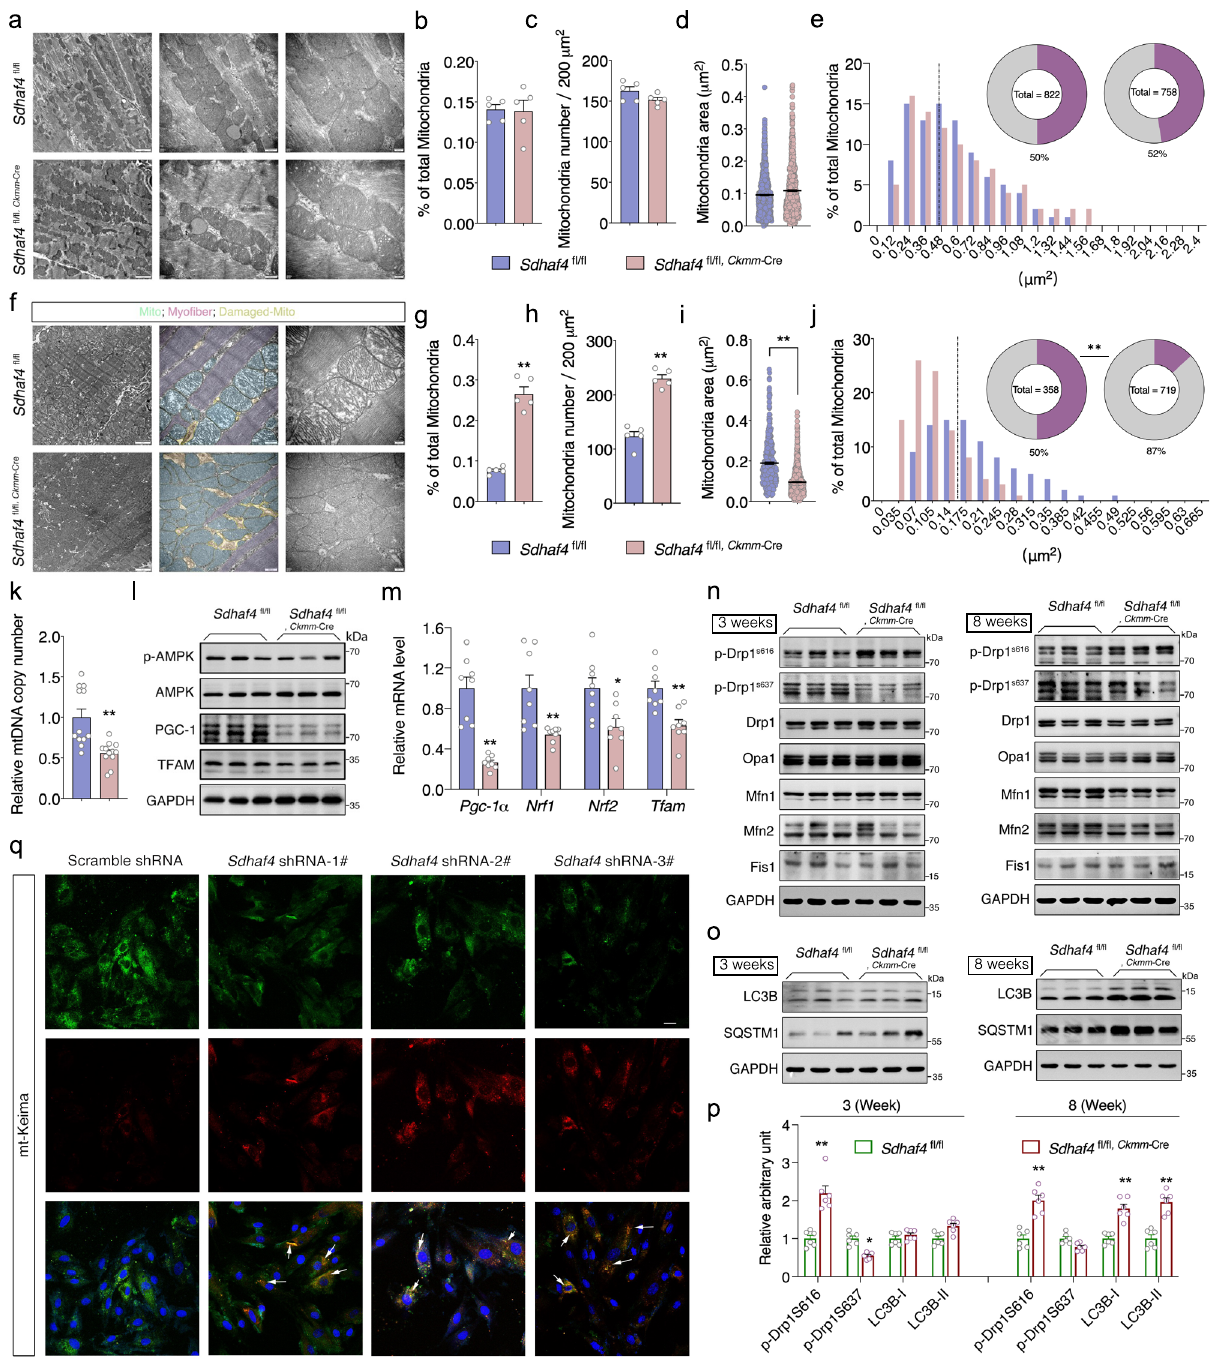
Fig. 6 Disrupted complex II assembly promotes mitophagy in heart. a – e Transmission electron microscope (TEM) analysis for left ventricles of hearts from WT and Sdhaf4 mutant mice at age of 3 weeks, representative images ( a , scale bar, 1 μ m, 500 nm, and 200 nm, respectively), ratio of abnormal mitochondria ( b , n = 5), mitochondrial number per section ( c , n = 5), average mitochondrial area ( d , n = 822 for WT, n = 758 for mutants), distribution pattern of mitochondrial area, ( e , n = 822 for WT, n = 758 for mutants). f – j TEM analysis for left ventricles of hearts from WT and Sdhaf4 mutant mice at age of 8 weeks, representative images ( f ), ratio of abnormal mitochondria ( g , n = 5, P < 0.0001), mitochondrial number per section ( h , n = 5, P < 0.0001), average mitochondrial area ( i , n = 358 for WT, n = 719 for mutants, P < 0.0001), distribution pattern of mitochondrial area, ( j , n = 358 for WT, n = 719 for mutants). k – m mtDNA copy number n = 12 ( P = 0.0003), immunoblots ( n = 3) and q P CR analysis ( n = 8, P = 0.00001, 0.005, 0.012, 0.001) of mitochondrial biogenesis related genes. n – p Immunoblots for mitochondrial fusion and fi ssion related proteins, LC3B and SQSRM1 in left ventricles of hearts from WT and Sdhaf4 mutant mice at age of 3 and 8 weeks respectively ( n , o representative blotting image; p summary analysis of arbitrary unit, n = 6, P = 0.0002, 0.011, 0.0001, 0.00011, 0.00001). q mt-Keima imaging in H9C2 cells transfected with Sdhaf4 shRNAs, arrows indicate mitophagy puncta, imaging data was collected by ZEN 2012 Blue edition (ZEISS, Jena, Germany), scale bar, 20 μ m ( n = 3 independent repeats per group). Values are mean ± SEM, * P < 0.05, ** P < 0.01. Statistical signi fi cance was determined by two-tailed Student ’ s t -test ( g – i , k , m , p ). Source data are provided in Source Data fi le.